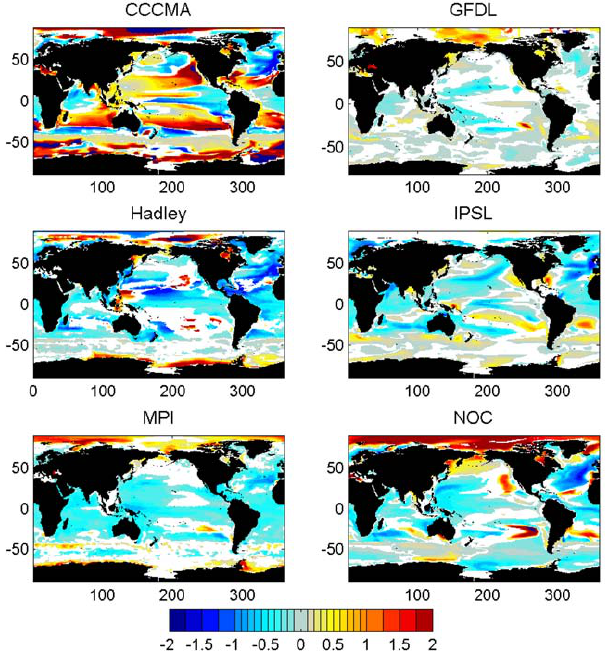
Figure 2: Trends in mean annual PP for 2006-2100 (expressed as average % change Fig. 3. Trends in PP seasonal amplitude for 2006–2100 (expressed Fig. 2. Trends in mean annual PP for 2006–2100 (expressed as av- as average % change per year) for 6 models forced with IPCC AR5 erage % change per year) for 6 models forced with IPCC AR5 sce- Figure 3: Trends in PP seasonal amplitude for 2006-2100 (expressed as average % per year) for 6 models forced with IPCC AR5 scenario RCP8.5. Only points where scenario RCP8.5. Only points where the trend is statistically signif- nario RCP8.5. Only points where the trend is statistically significant change per year) for 6 models forced with IPCC AR5 scenario RCP8.5. Only points the trend is statistically significant at the 95% level are plotted. icant at the 95% level are at the 95% level are plotted. where the trend is statistically significant at the 95% level are plotted. .